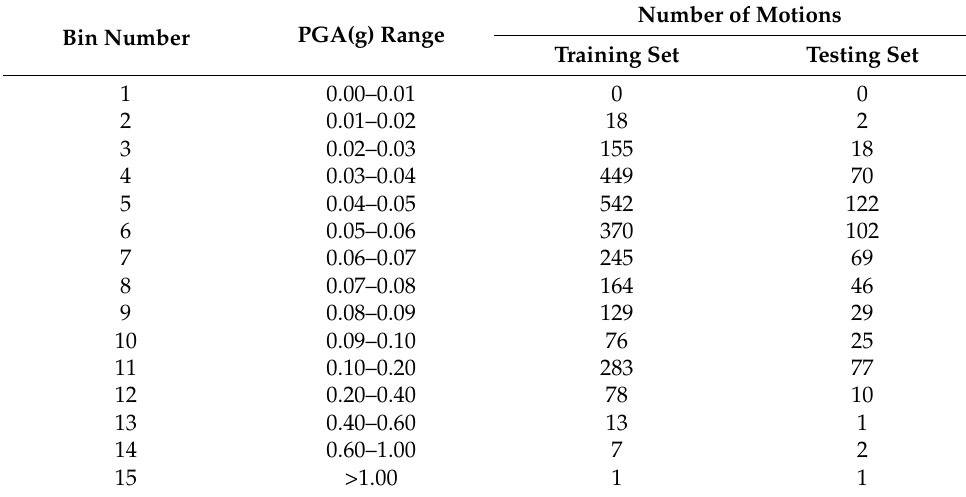
Figure 10. Histogram of the ratio of XGBoost for predicted and observed PGA.